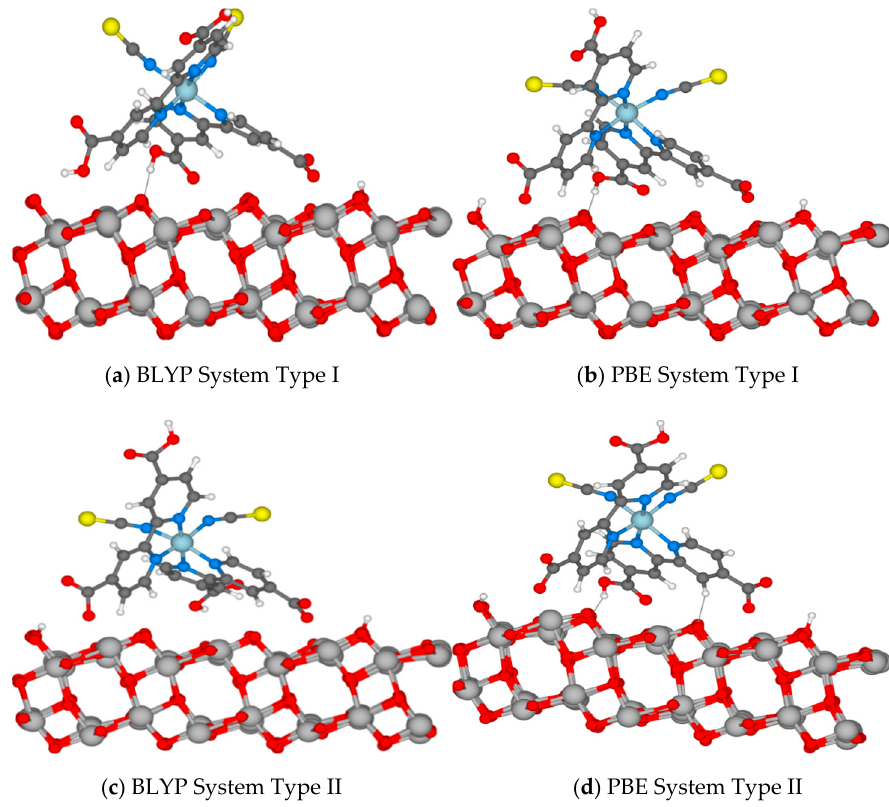
Figure 1. Relaxed geometries of the systems after ~8–9 ps of BOMD. Carbon is shown in dark grey, nitrogen in blue, oxygen in red, hydrogen in white, titanium in light grey, sulphur in yellow and ruthenium in light green. System types I: unsolvated, II: solvated with [bmim][I]. Solvated systems omit the solvent for ease of viewing.